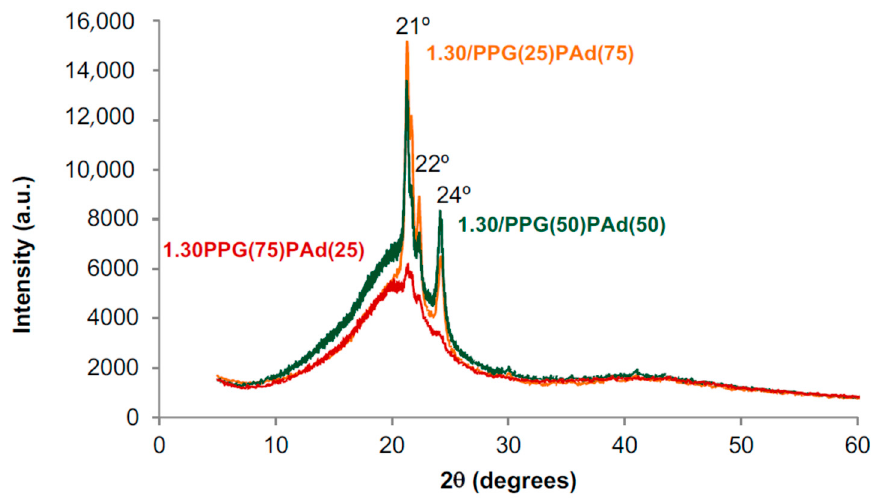
Polymers 2021 , 13 , x FOR PEER REVIEW 12 of 25